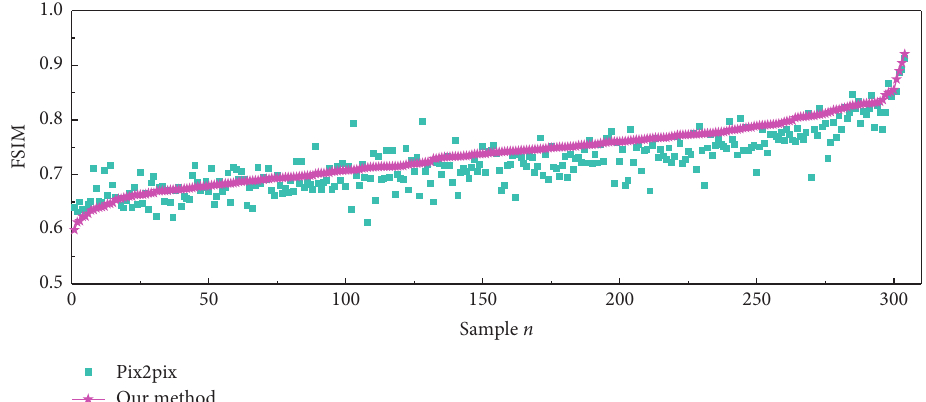
Figure 10: The FSIM results between the real infrared images and the infrared images generated by our method and the Pix2pix. The X -axis represents different test samples and the Y -axis represents the FSIM value corresponding to the